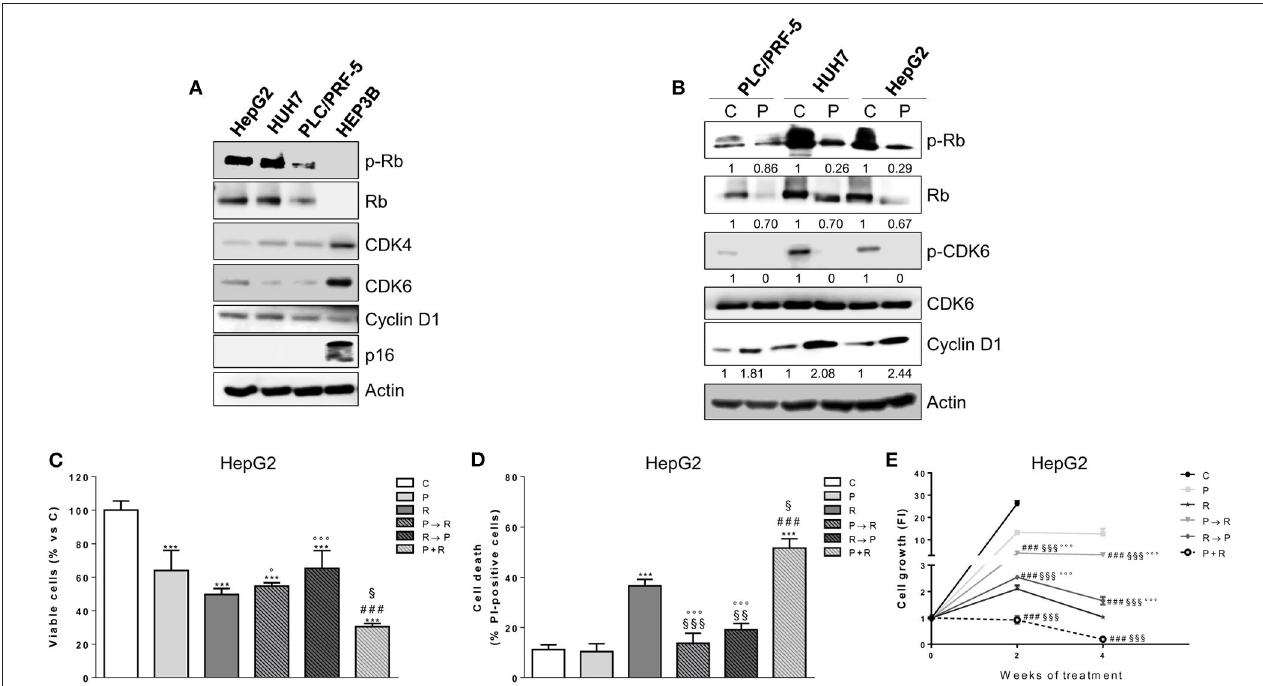
FIGURE 1 | Palbociclib alone inhibits the proliferation of Rb-positive HCC cell lines and in simultaneous combination with regorafenib enhances its cytotoxicity. (A) HCC cells (HepG2, HUH7, PLC/PRF-5, and HEP3B) were analyzed by Western blotting for the basal expression of cell cycle regulatory proteins. (B) PLC/PRF-5, HUH7, and HepG2 cell were untreated (Control, C) or treated with 1 µ M palbociclib (P) for 24h. The cells were lysed and the expression of the indicated proteins was evaluated by Western blotting. HepG2 cells were treated with 0.1 µ M P or 1 µ M regorafenib (R) for 48h or with different combinations of the two drugs: P for 24h followed by R for 24h (P → R), R for 24h followed by P for 24h (R → P), or a simultaneous combination for 48h (P + R). The cells were counted using the trypan blue dye exclusion method (C) and the percentage of cell death was evaluated after Hoechst 33342 and PI staining (D) . Data are expressed as percent vs. control or as percent of dead cells, respectively. *** p < 0.001 vs. C; ### p < 0.001 vs. P; § p < 0.05, §§ p < 0.01, §§§ p < 0.001 vs. R; ◦ p < 0.05, ◦◦◦ p < 0.001 vs. P + R. (E) HepG2 cells were treated with the different schedules reported in panels (C,D) for 2 or 4 weeks. The growth medium with drugs was refreshed every 3 days. Cell proliferation was evaluated by CV assay. Data are expressed as Fold Increase (FI). The FI index was calculated as the ratio between cell proliferation after 2 or 4 weeks and cell proliferation at T 0 (T 0 = 24h after seeding). ### p < 0.001 vs. P; §§§ p < 0.001, vs. R; ◦◦◦ p < 0.001 vs. P + R. All the data reported are representative of two independent